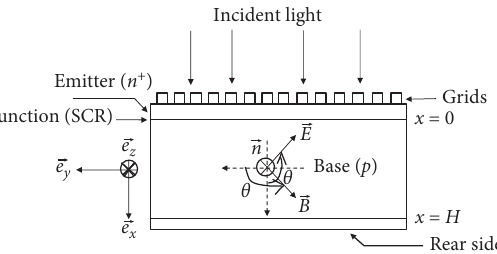
Figure 1: Illuminated silicon PV cell under reverse polarisation of an electromagnetic field. Table 1: Intensity of the electric and magnetic fields for different distances separating the PV cell and the antenna. Distance r (m)